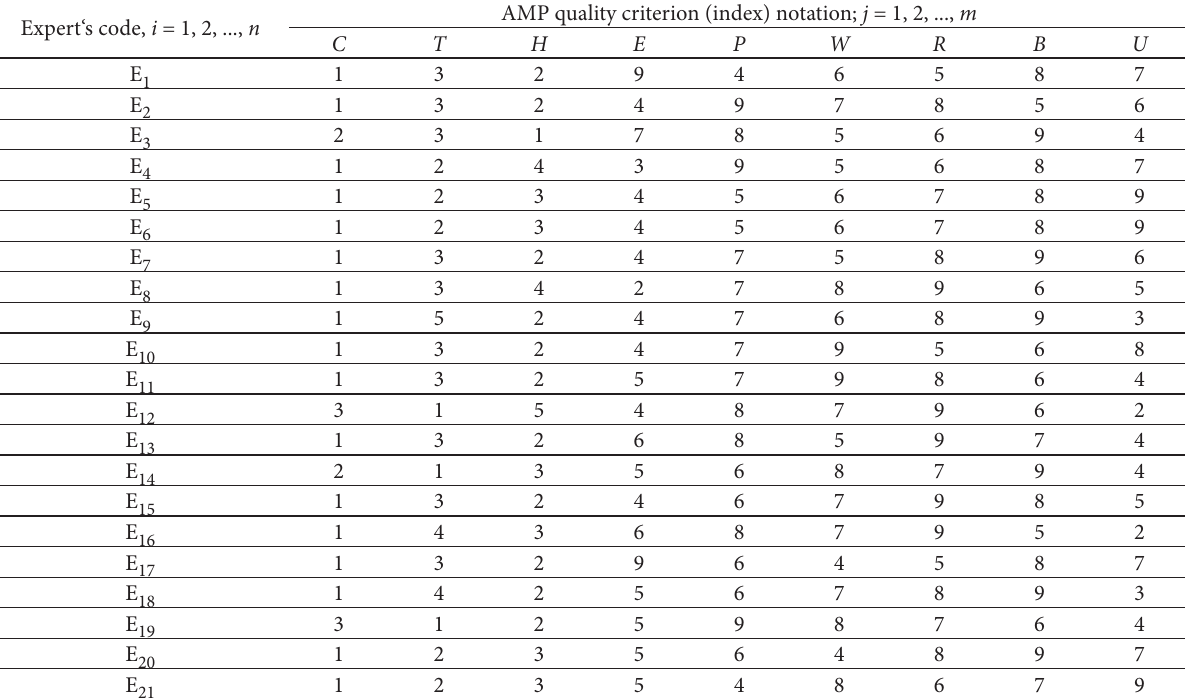
Table 4. Ranks R ij of the operating (not newly purchased) AMP quality criterion (indices) and values calculated from them Expert‘s code, i = 1, 2, ...,